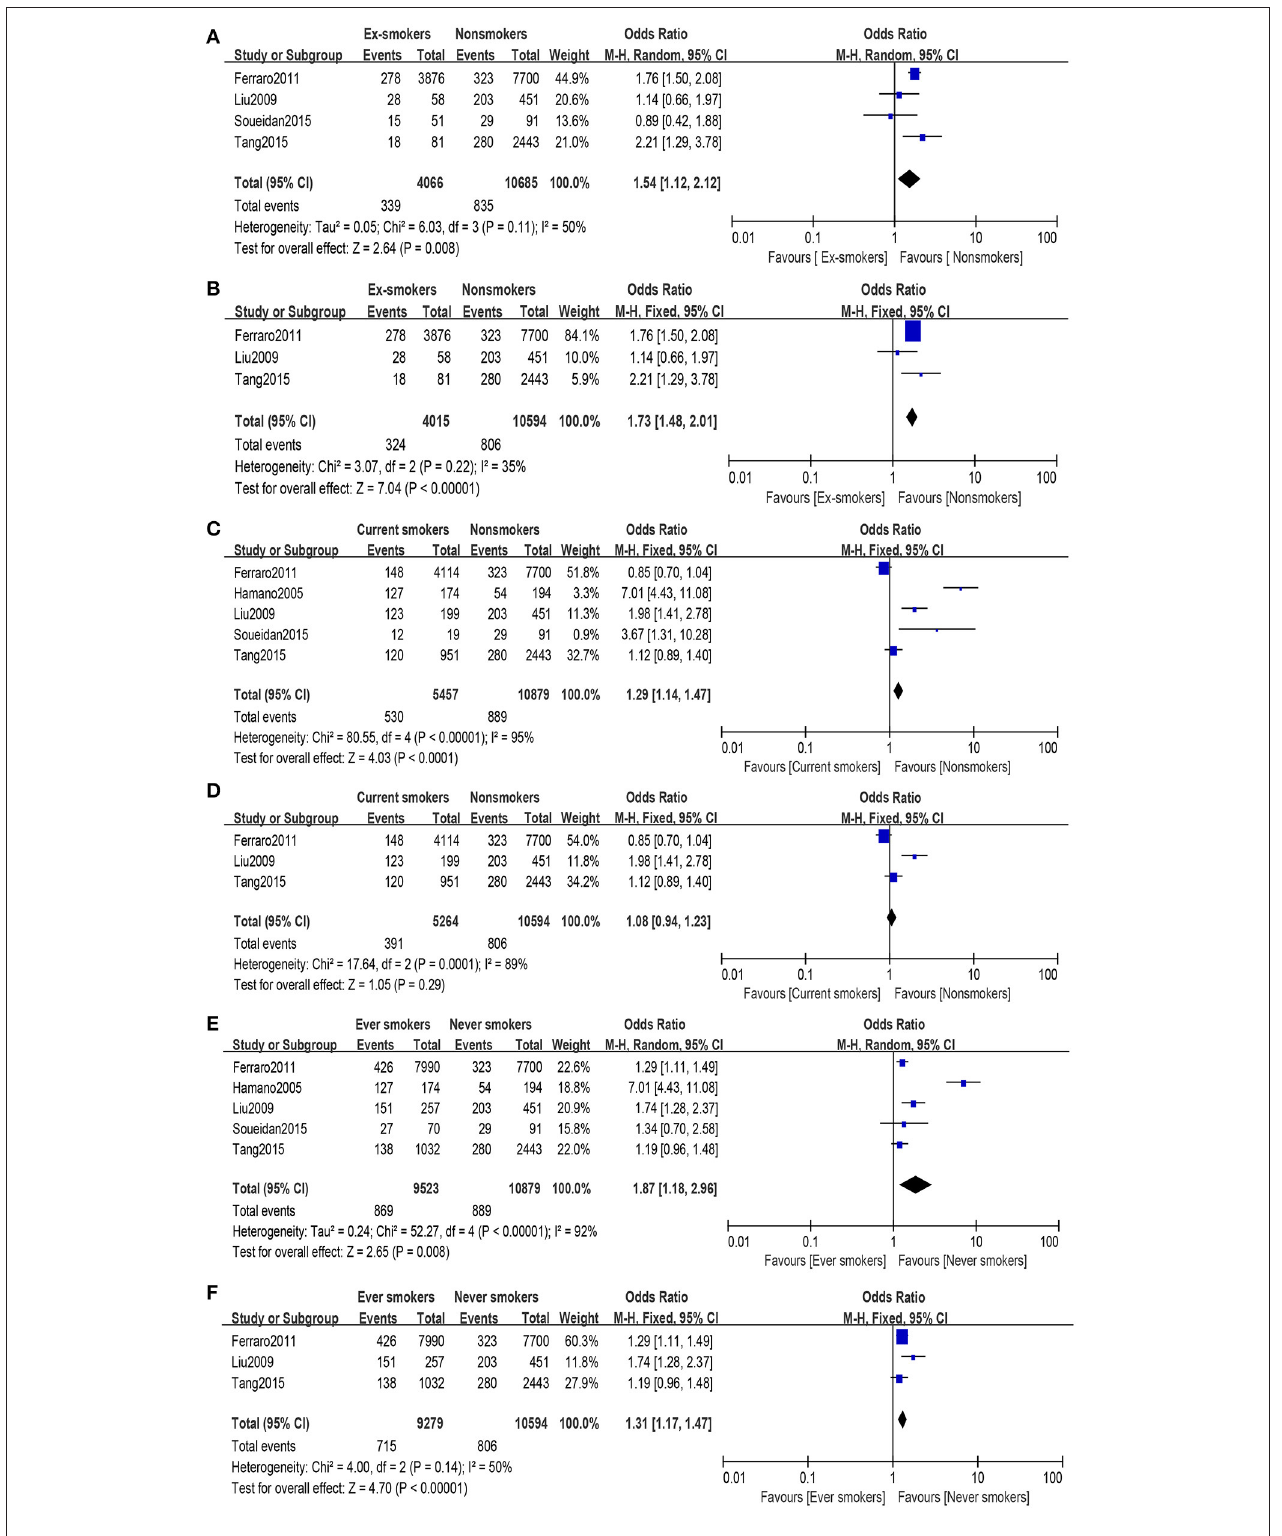
FIGURE 2 | Forest plot: (A) comparison of ex-smokers vs. non-smokers and risk of urolithiasis, (B) comparison of ex-smokers vs. non-smokers and risk of urolithiasis after eliminating the lowest-quality article, (C) comparison of current smokers vs. non-smokers and risk of urolithiasis, (D) comparison of current smokers vs. non-smokers and risk of urolithiasis after eliminating the lowest-quality article, (E) comparison of ever-smokers vs. never-smokers and risk of urolithiasis, and (F) comparison of ever-smokers vs. never-smokers and risk of urolithiasis after eliminating the lowest-quality article.